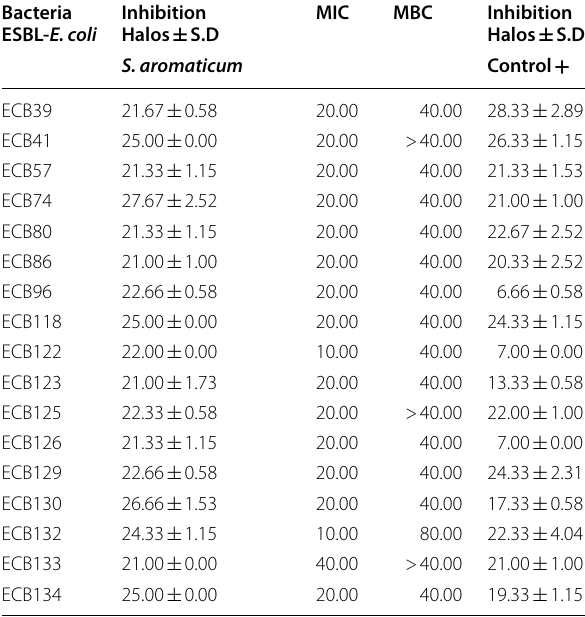
Positive control: (chloramphenicol); inhibition halos: mean data and standard deviation (S.D) (mm), MIC: minimum inhibitory concentration (mg/mL); MBC: minimum bactericidal concentration (mg/mL)